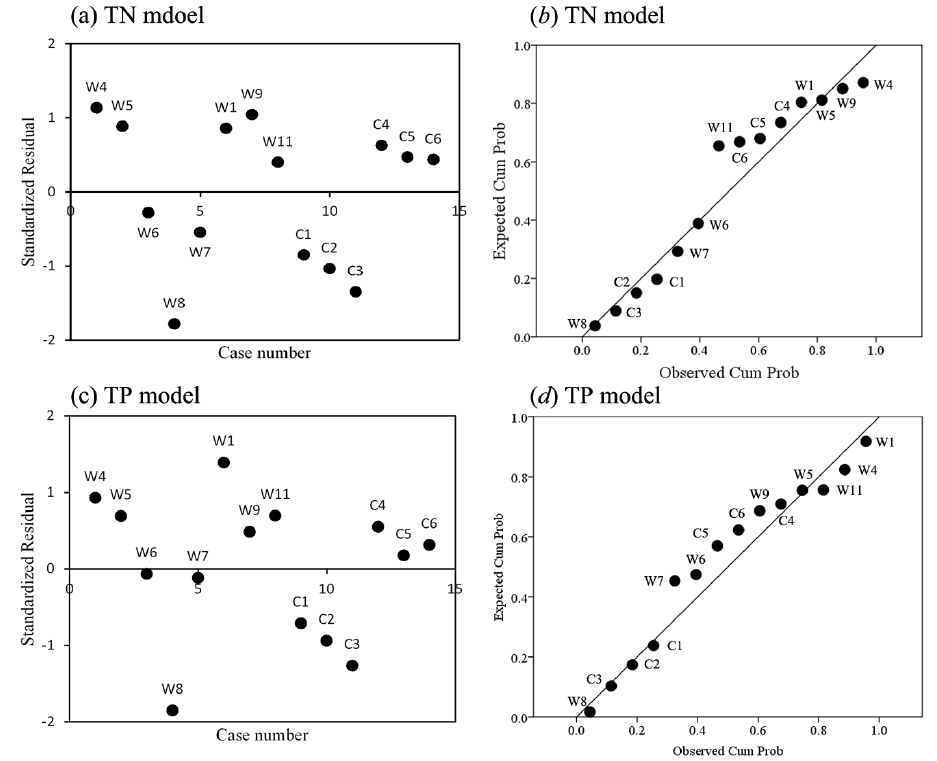
Figure 5. Standardized residual plot ( a , c ) and Normal P-P plot of regression standardized residual ( b , d ) of MLR